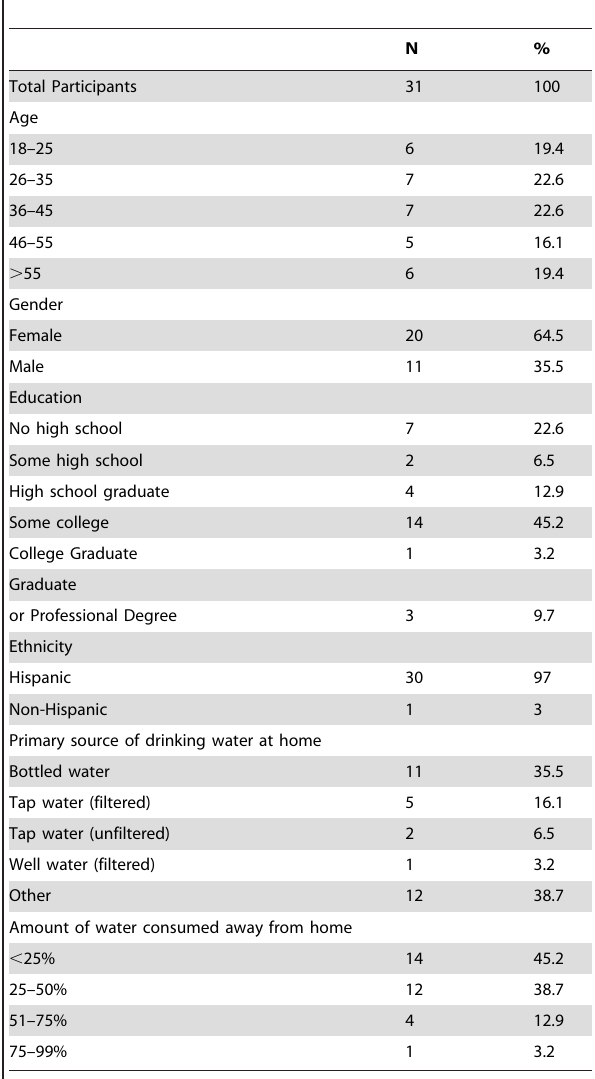
Table 1. Participant Characteristics, Imperial County,